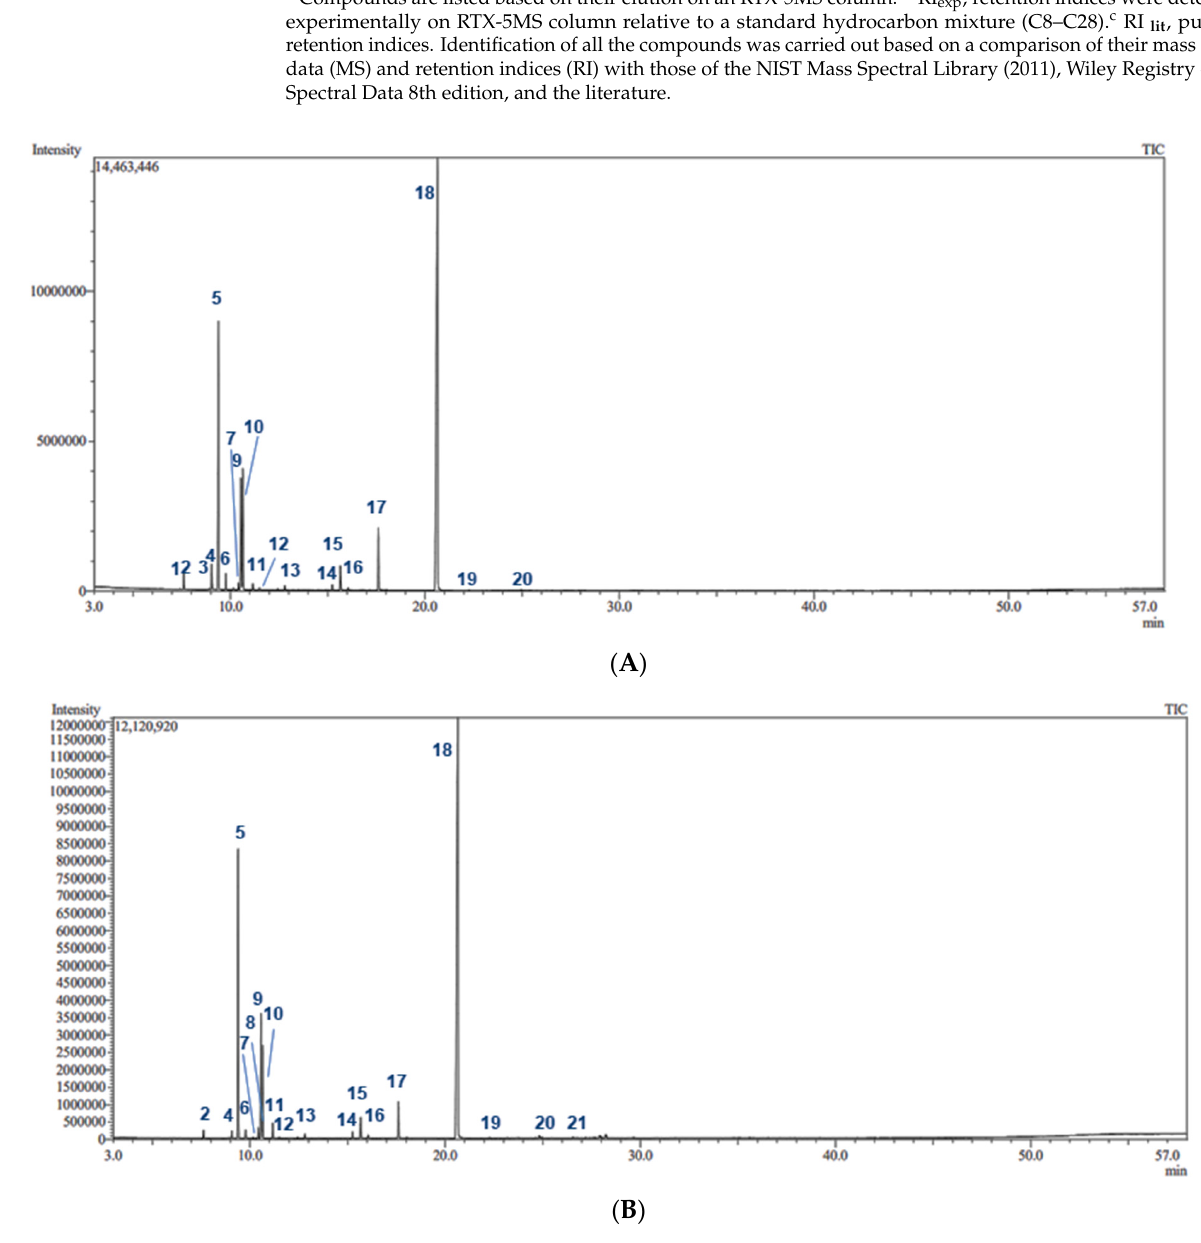
Figure 1. GC-MS chromatograms of P. racemosa leaf ( A ) and stem ( B ) essential oils on the Rtx-5MS column.